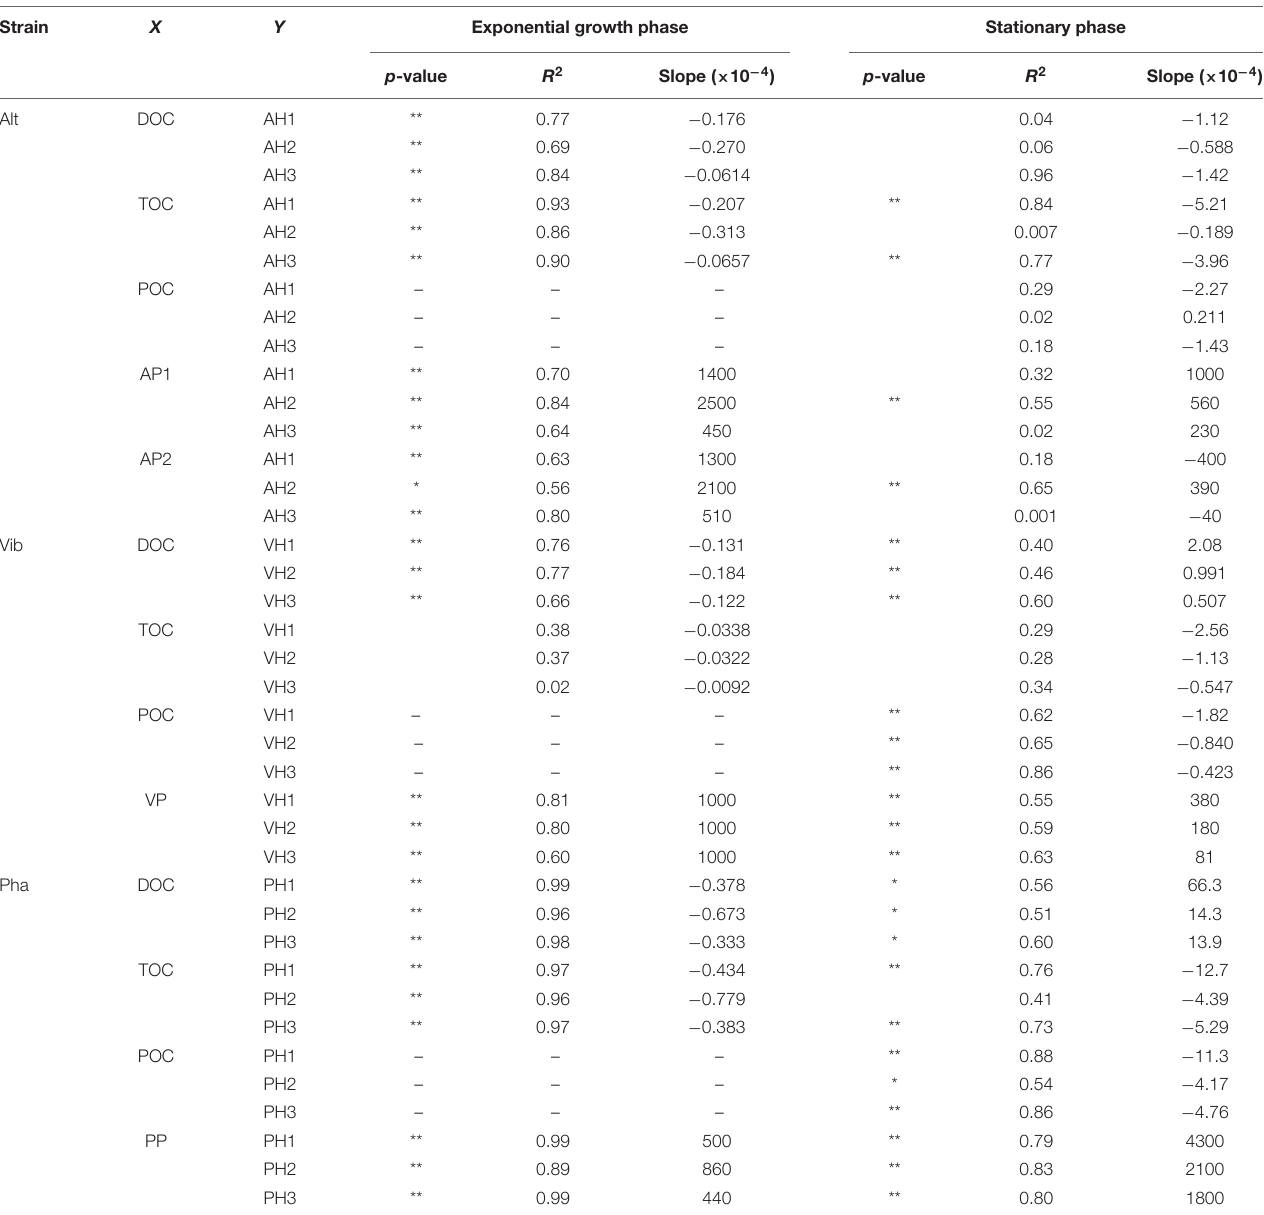
TABLE 3 | The results of a regression analyses between humic-like FDOM and other parameters in the treatments of three bacterial strain. Strain X Y Exponential growth phase Stationary